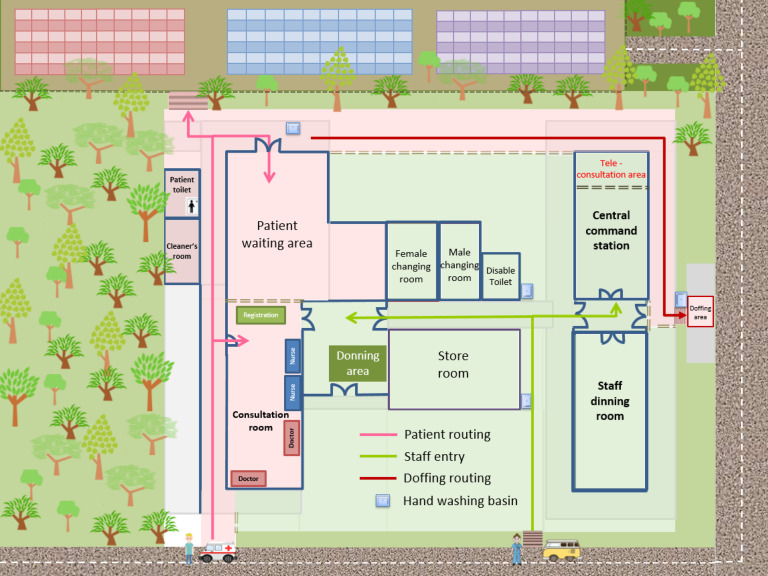
Layout and workflow of the community isolation facility (CIF) at Lei Yue Mun Park and Holiday Village. Note. Patient area (red zone) and staff area (green zone) are marked in red and green as the background colors, respectively. Healthcare workers (HCWs) were assigned a designated entrance and route to the central command station to report duty during the day or night shift. HCWs wore full personal protective equipment (PPE) with surgical respirator (ie, N95 respirator), cap, face shield, isolation gown, and gloves in the donning area before entering the consultation room. Upon ambulance arrival, HCWs with full PPE went out from the consultation room to escort patients from the ambulance drop-off point to the consultation room, where registration and clinical assessment were performed. Subsequently, patients were escorted to the patient waiting area to receive basic infection control training with emphasis on hand hygiene and wearing surgical mask, and to learn the housekeeping activities such as self-collection of deep throat saliva in the early morning, self-monitoring of blood pressure, pulse, and body temperature, the using of teleconsultation system inside patient rooms, as well as the delivery of meals and linens and disposal of wastes from the bungalows. HCWs then escorted patients to the assigned bungalow. Each bungalow occupied by either 1 patient or 1 family of 2 persons. HCWs returned from the bungalows, following a designated route for doffing and went to the central command station or staff dining room.